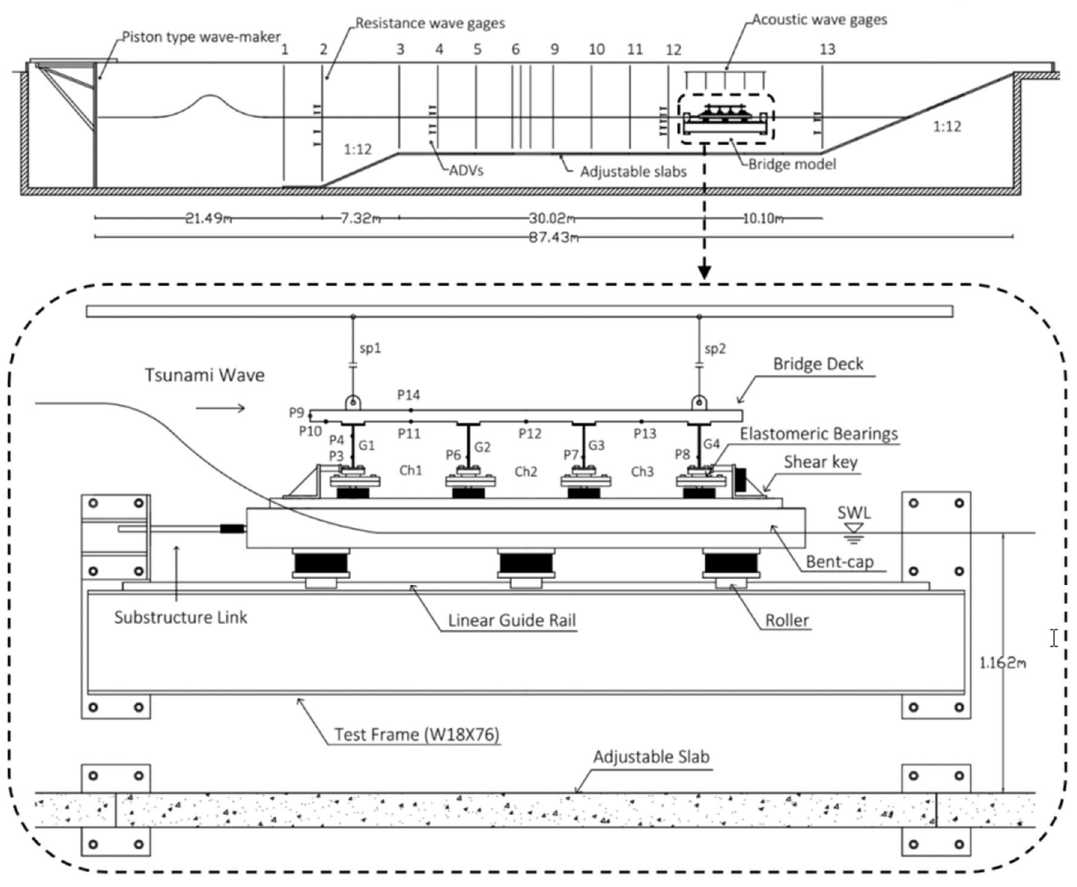
Figure 1. Experimental setup of the hydrodynamic experiments depicting the wave flume ( top ) and the bridge model ( bottom ), with the main components and the corresponding instrumentation. (SWL = still water depth, G = girder, Ch = chamber, P = pressure gage, sp = string pot).